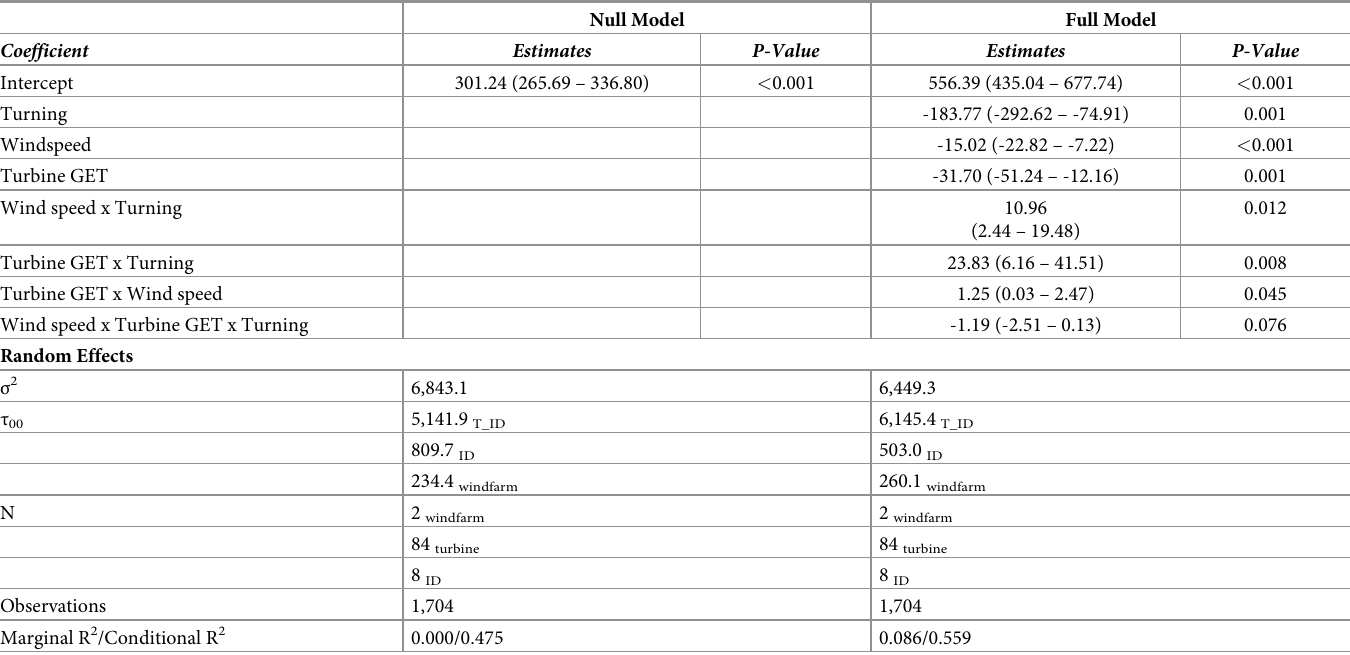
Table 4. Summary statistics for the best GLMM (Model 22: Table 3) examining 3-D distance of eagle flight line records to the vicinity of a turbine location in after- operation analyses: Turbine GET = GET score at the turbine location, Wind speed = mean wind speed at the turbine hub in a 3 hour period (m s -1 ), turning indicates if the turbine blade was still or turning at the time of a bird